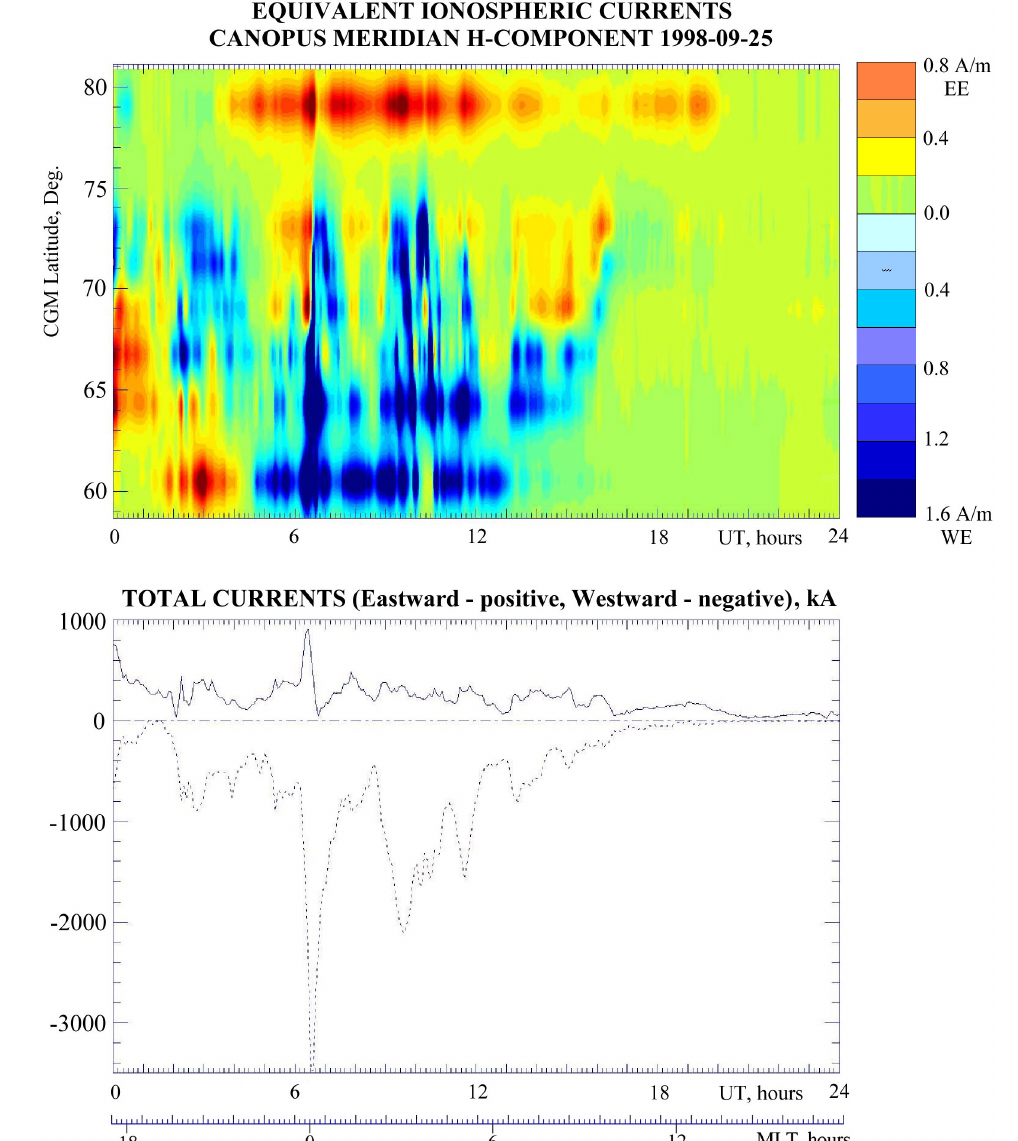
Fig. 4. As Fig. 3, but for the CANOPUS meridian chain of magnetic